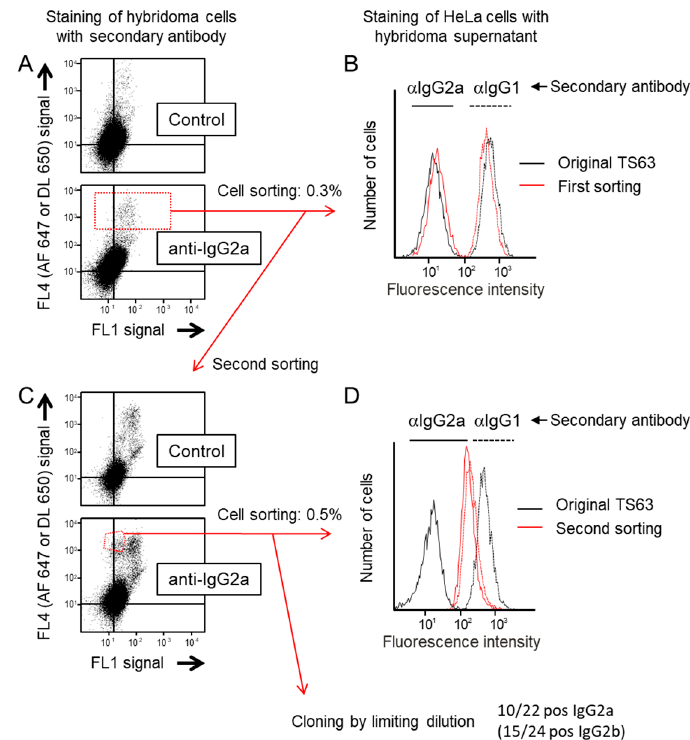
Figure 1. Selection of IgG2a variants of TS63. ( A ) Hybridoma cells were labelled with either a control secondary antibody (a goat anti-rabbit coupled to Dylight 650 (DL 650)) or a goat anti-mouse IgG2a coupled to Alexa Fluor 647 (AF 647). The dot plots show for each cell the value of the Dylight 650 or Alexa 647 fluorescence in the far red Channel (FL4) and that of the autofluorescence in the green channel (FL1). Note that there is no difference between the two labelings indicating that most of the “positive” signal is non-specific. The gate used to sort the cells with the highest level of staining is drawn in the bottom dot-blot. ( B ) After being grown for a few days, the supernatant of the sorted cells was used to stain HeLa cells by indirect immunofluorescence, using either anti ( α )-IgG1 or anti-IgG2a polyclonal antibodies coupled to Alexa 647 as secondary reagents. A staining with the conditioned medium of parental TS63 cells was performed in parallel. The fluorescence staining of the cells was analyzed by flow-cytometry. Note that the supernatant of sorted cells stains HeLa cells slightly better than that of parental cells when the binding of the mAb is revealed by an anti-IgG2a antibody. ( C) After amplification, the cells sorted in A were subjected to a second sorting. Note that there is a specific cell population uniquely detected by the anti-mouse IgG2a labeling. The gate used to sort the cells is drawn in the bottom dot-blot. ( D ) Labelling of HeLa cells as in B after growing the cells sorted the second time for a few days. Note that the staining of HeLa cells by the supernatant of the sorted cells is similar whether the binding of the mAb is revealed by an anti-IgG2a antibody or an anti-IgG1 antibody.